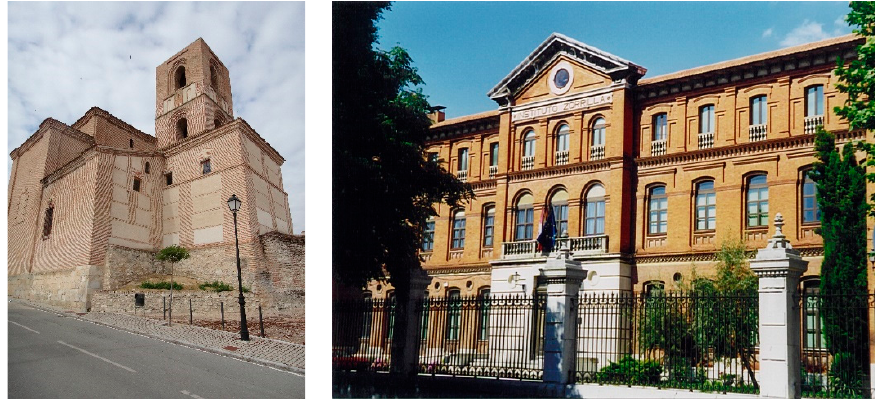
Figure 1. On the left, Mudejar church of Arévalo, Ávila (handmade bricks), and on the right, Institute Zorrilla, Valladolid (mechanical bricks).